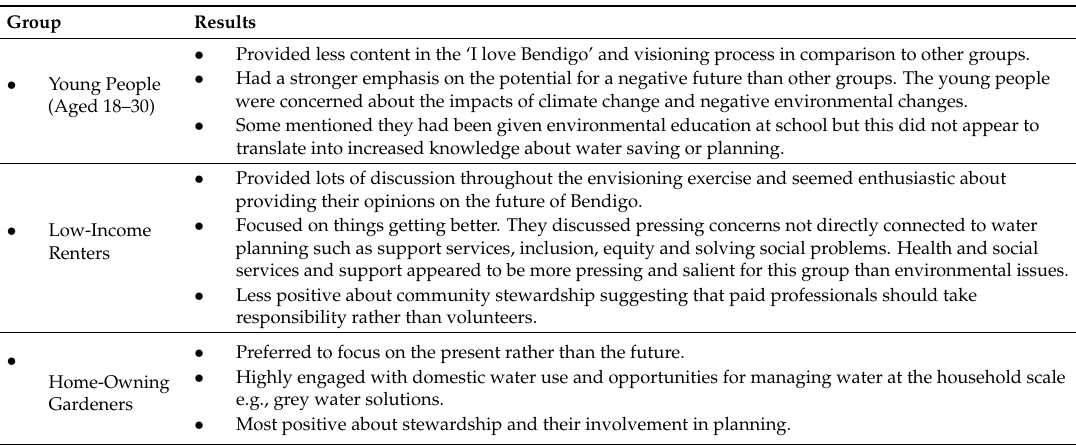
Table 1. Differences in the water sensitive vision for